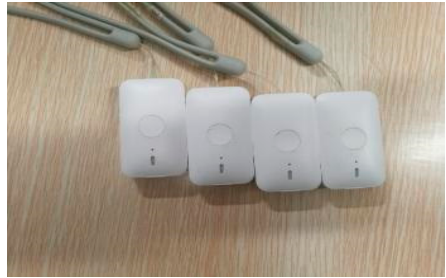
Figure 3. The appearance of the GPS